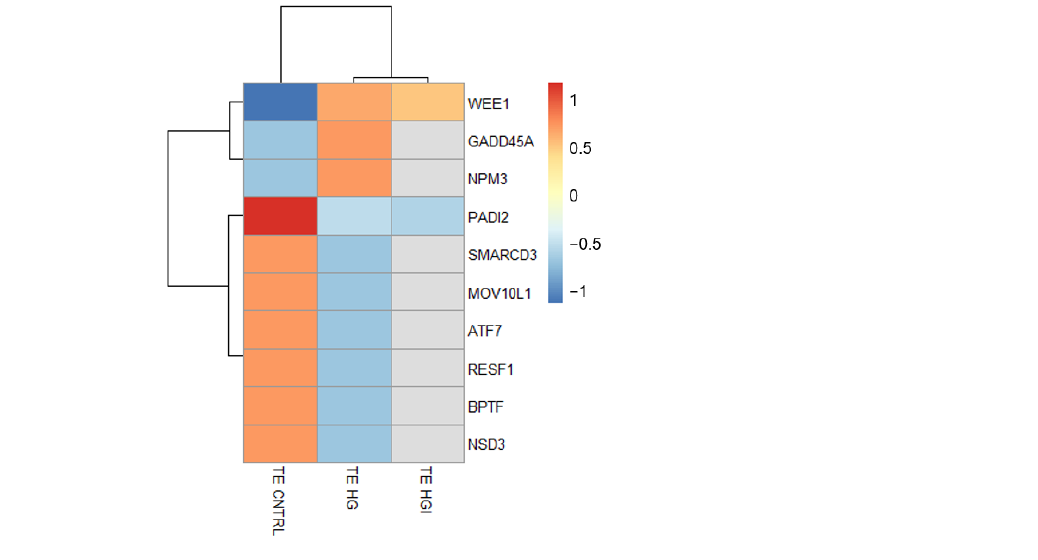
Figure 8. Heatmap showing the differential expression of genes (DEG) with a role in epigenetic regulation in HG and HGI TE compared to CNTRL TE. The mean normalized expression counts of n = 3 biological replicates, transformed to a z-score, are represented by the color key. The gray color indicates that the gene is not a DEG in that group. ICM, inner cell mass. TE, trophectoderm.